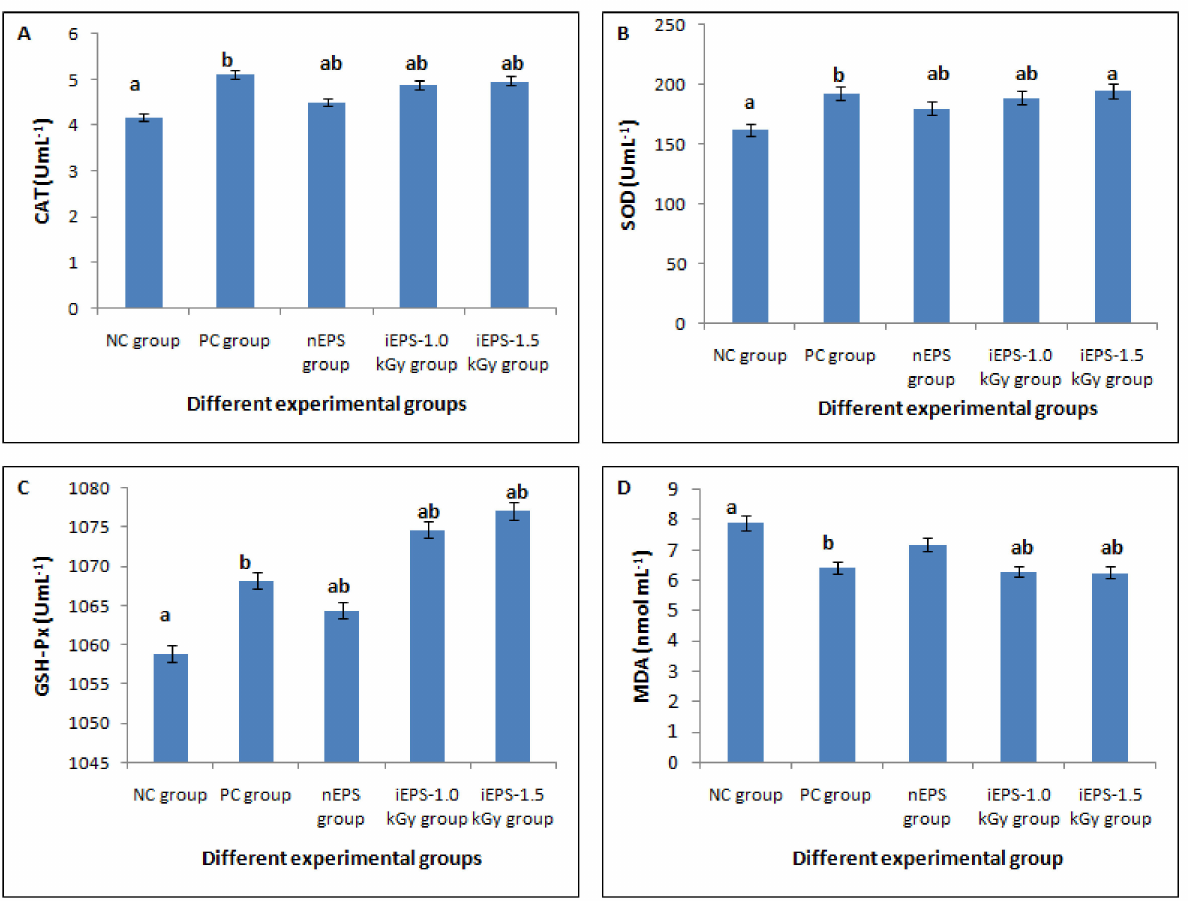
Figure 7. Effects of nEPS and iEPSs on the levels of antioxidant enzymes ( A ) CAT, ( B ) SOD, ( C ) GSH -PX, and ( D ) MDA content in mice. a–b with different letters means significantly different at p <